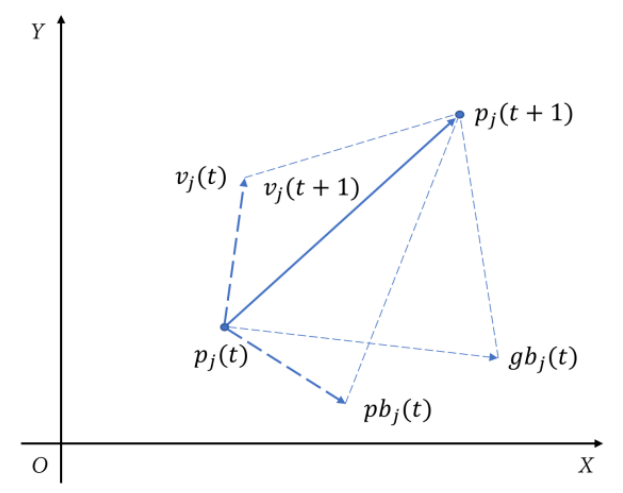
Figure 6. Schematic diagram of the general particle swarm algorithm.